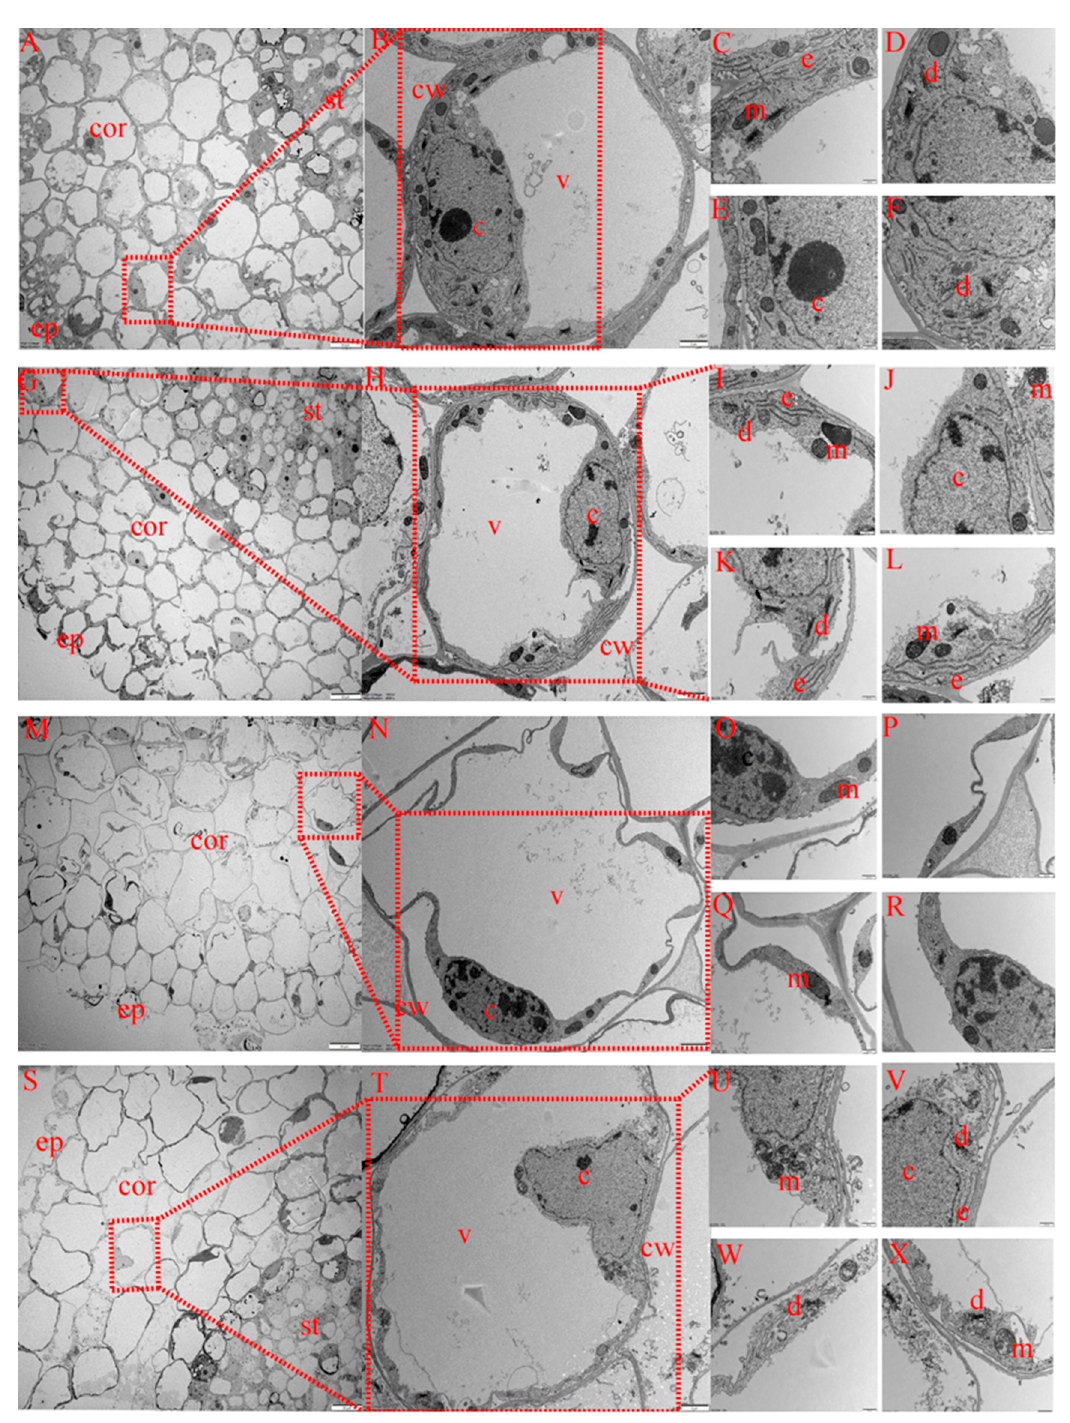
Figure 7. Effects of melatonin on root cortex cell ultrastructure of cotton seedlings under salt stress. ( A – F ) Transmission electron micrograph (TEM) of the cortex cell structure under control (CK) treatment; ( G – L ) TEM of the cortex cell structure under melatonin (MT) treatment; ( M – R ) TEM of the cortex cell structure under NaCl (S) treatment; ( S – X ) TEM of the cortex cell structure under the combined melatonin and NaCl (MS) treatment. ep, epidermis; cor, cortex; st, stele; m, mitochondrion; e, endoplasmic reticulum; d, dictyosome; c, cell nucleus; v, vacuole.